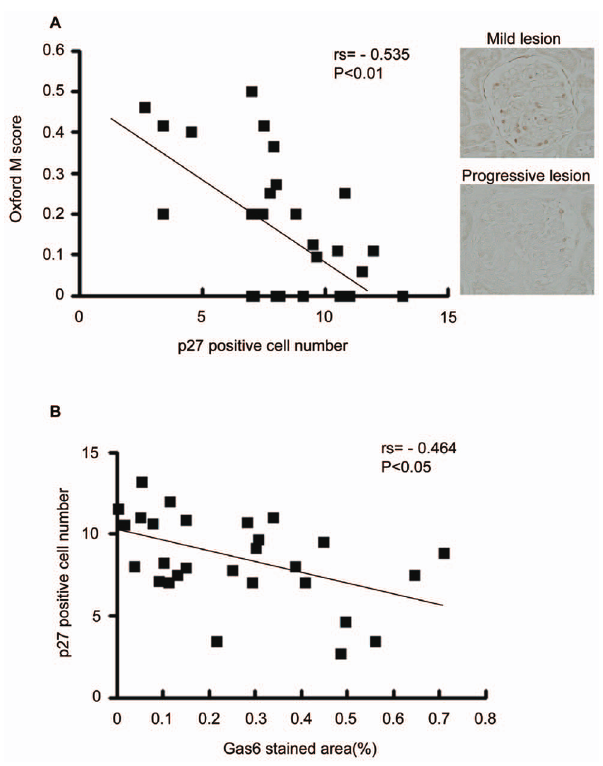
Figure 4. Inverse correlation of Gas6 stained area with p27 positive cell number. (A) Biopsy samples were immunostained using indirect immunohistochemistry procedure with anti-p27 antibody. p27 positive cell number was counted. The result was divided by glomeruli number. For each sample, at least eight glomerular profiles per patient were measured. p27 positive cell number correlated with Oxford mesangial hypercellularity score. (B) Gas6 stained area inversely correlated with p27 positive cell number. N=28. Oxford M score,